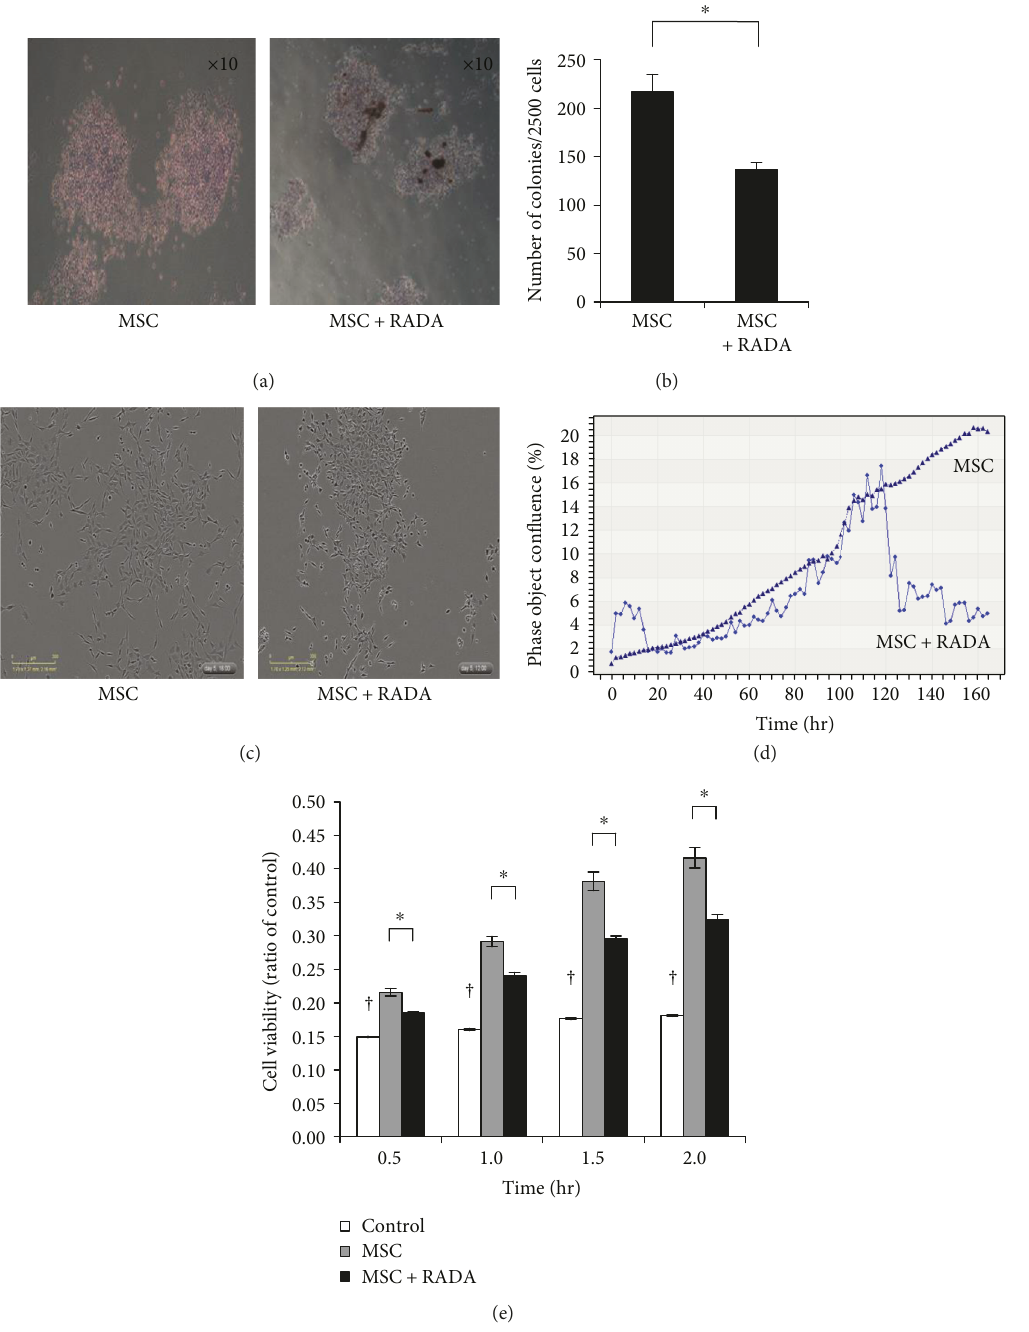
Figure 1: Combination of MSCs with RADA in in vitro cultures, demonstrating that their combination showed lower cell viability than MSCs alone. (a) Representative cell culture showing formation of colonies by MSCs and the combination of MSCs and RADA (10x magni fi cation). (b) Quanti fi cation of colonies formed by MSCs and MSCs+RADA. The combination group showed signi fi cantly lower colony-forming units than MSCs alone. (c) Representative cell culture showing survival of MSCs and the combination of MSCs and RADA after 160 hours of live culture (10x magni fi cation), showing an overall lower number of cells in the combination group compared to MSCs alone. (d) The lower cell growth in the combination group is shown in this quanti fi cation of cell growth for MSCs alone and MSCs+RADA, as measured by live cell screening analysis. (e) Quanti fi cation of cell viability by MTT assay also demonstrates that MSCs+ RADA showed signi fi cantly lower cell viability than MSCs alone when compared to control. † p < 0 05 for control versus all other groups. ∗ p < 0 05